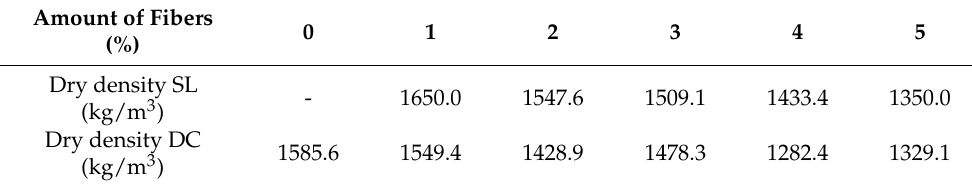
Table 3. Density values in static compaction (SL) and dynamic compaction (DC).